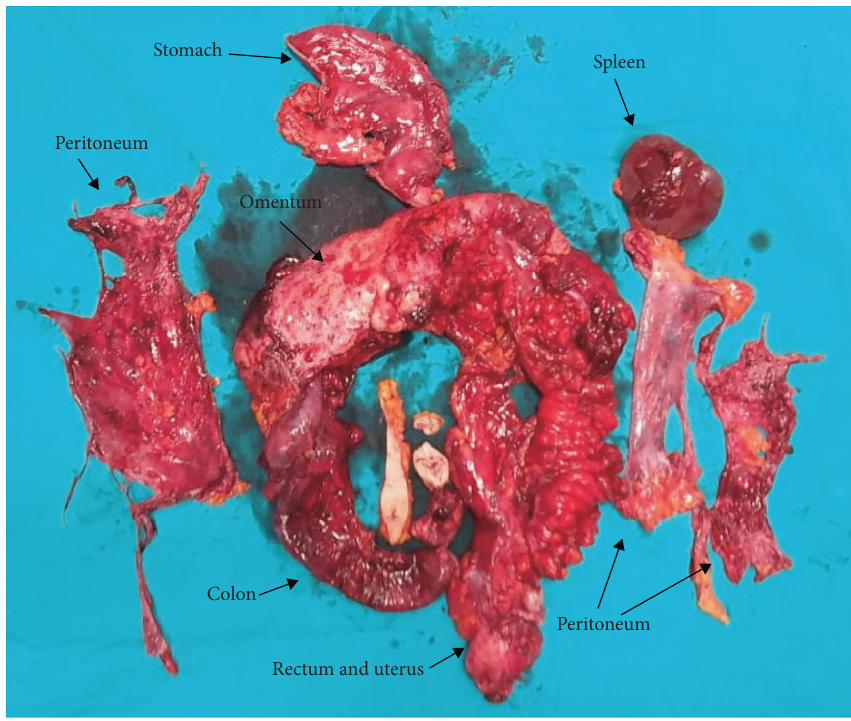
Figure 2: Surgically resected tissues.